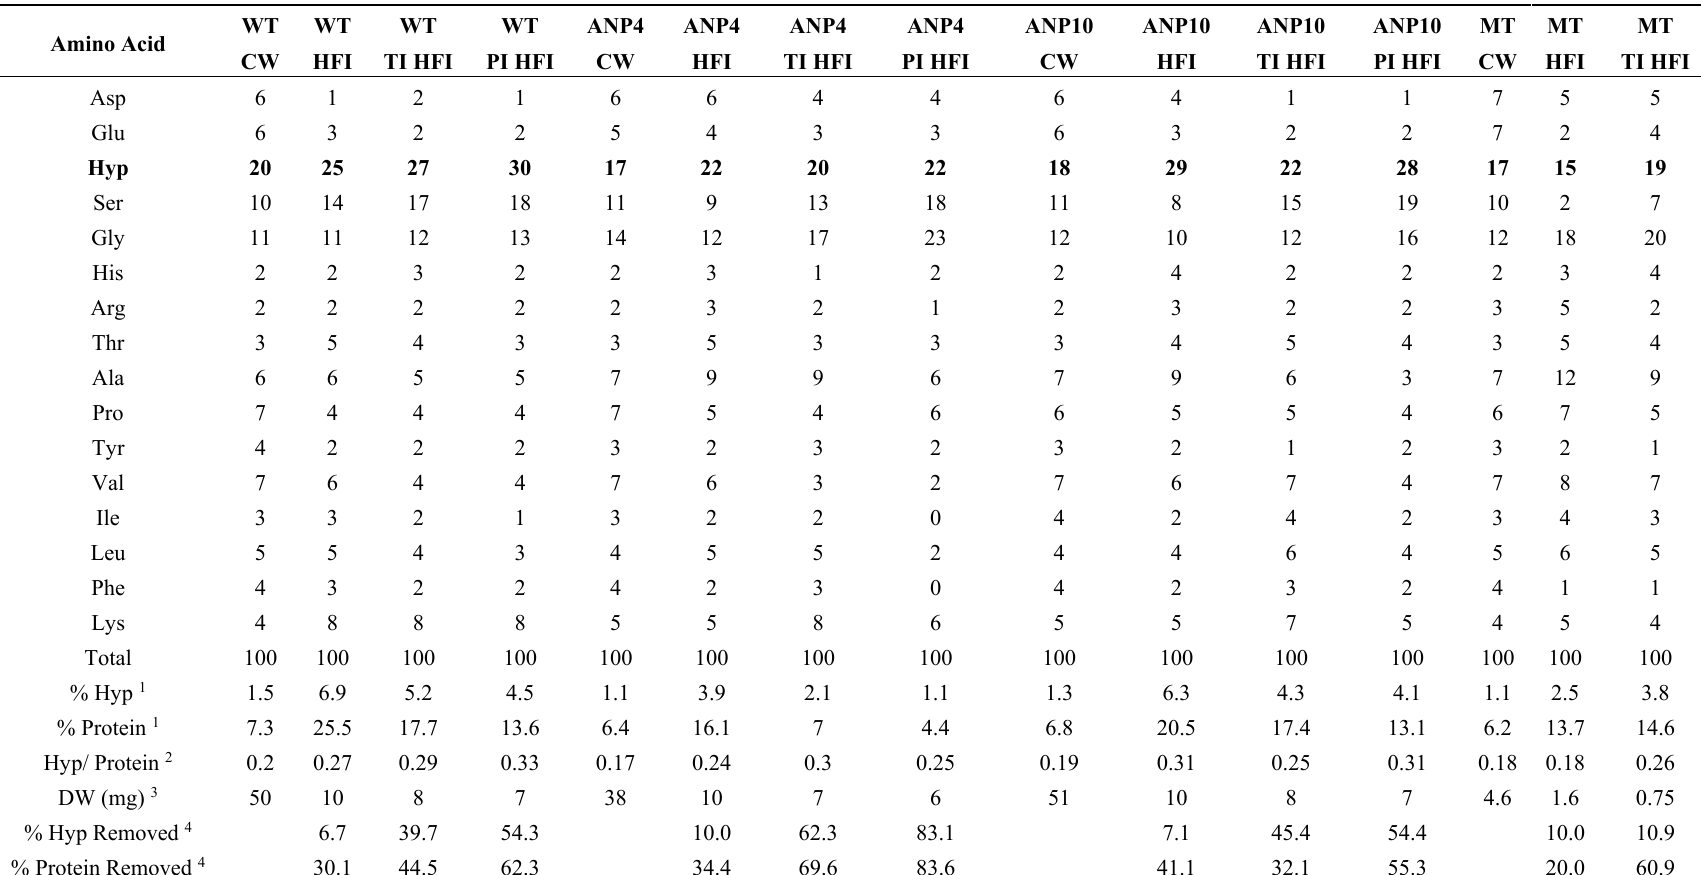
Table 1. Amino Acid Composition (mole %) of the Root Cell Wall (CW), Insoluble Cell Wall Pellet Remaining after Treatment with HF (HFI), Trypsin (TI HFI) and Pronase (PI